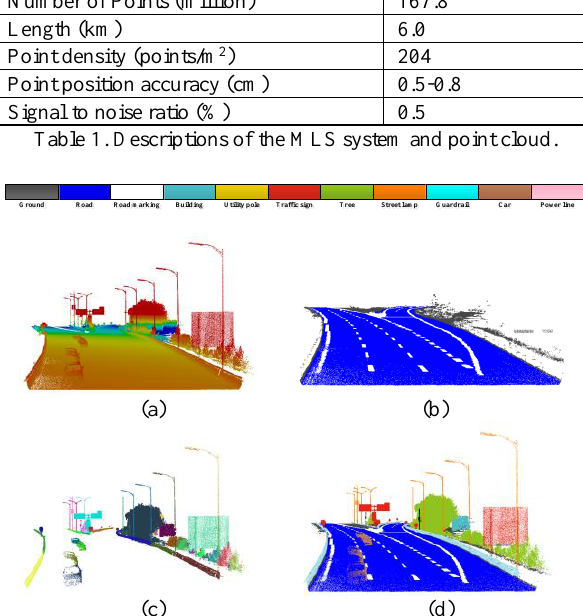
Figure 9. Road features extraction result of testdata: (a) original point clouds, (b) road surface features extraction result, (c) non- ground points segmentation, and (d) objects